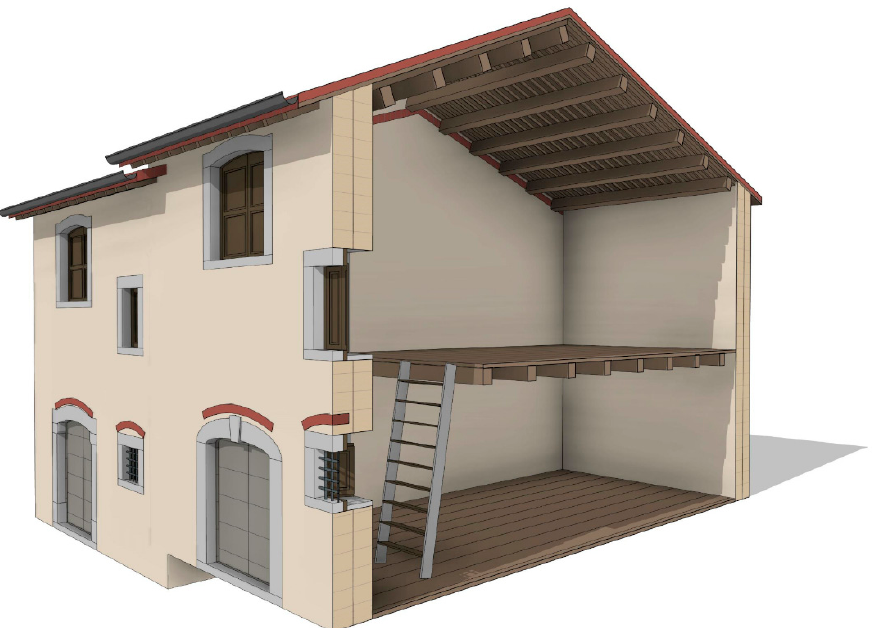
Figure 13. HBIM model of a case study building in the historic centre of Cornillo Nuovo—SISMI project [41].